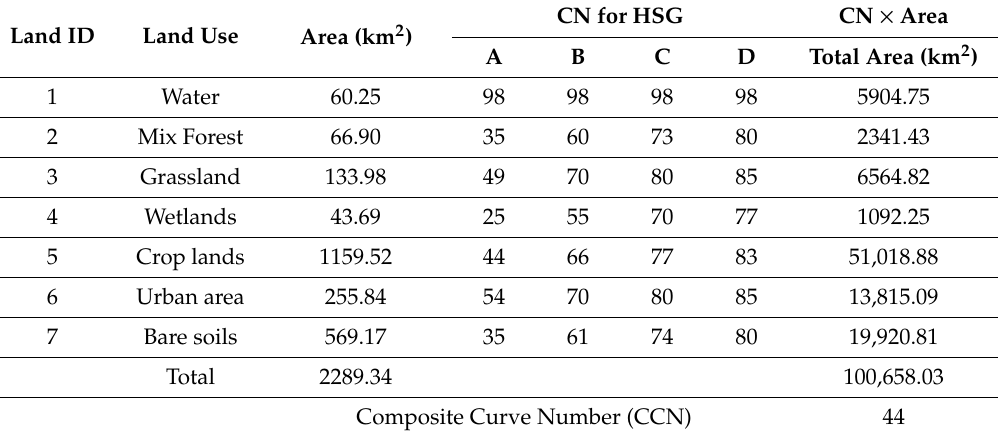
Table 2. The list modified Curve Number (CN) for the CRGB.